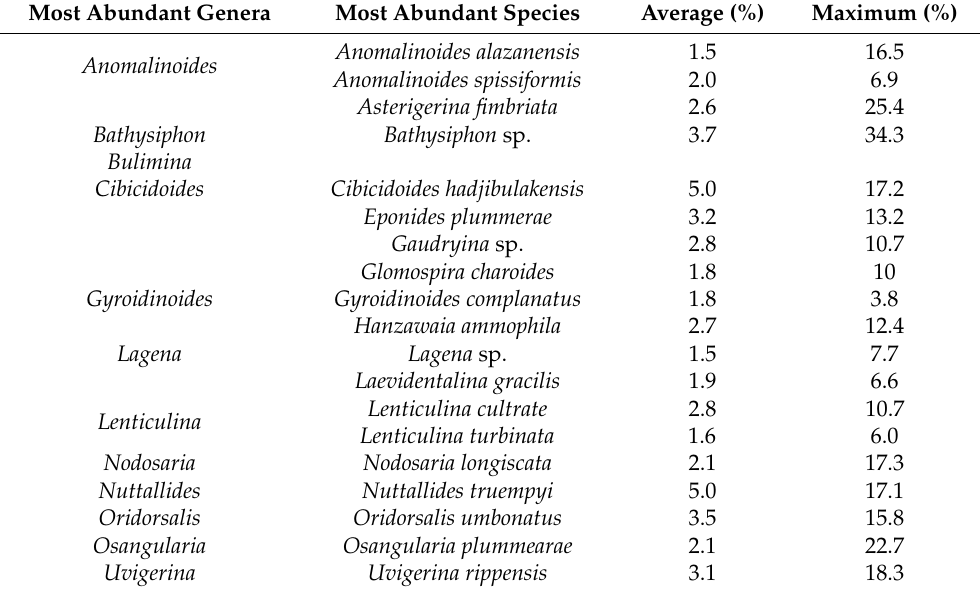
Figure 3. Indices of carbonate dissolution and benthic foraminiferal assemblage’s parameters from the Baskil section. P/B: planktic to benthic (P/B) ratio calculated as P/(P + B) × 100 expressed as percentages of planktonic foraminifera in the total foraminiferal assemblage; FI: Fragmentation index calculated according to [60]; C/A: calcareous-agglutinated ratio expressed as C/(A + C) × 100; B/triserial: percentages of bi-triserial morphogroups; E/I: epifaunal to infaunal (E/I) ratio calculated as E/(E + I) × 100; S: species richness; Fisher α index, H’: Shannon index; D: dominance; J: evenness, E: equitability (calculated using the PAST—Palaeontological Statistics data analysis package, [72]). Magneto-biostratigraphy and lithostratigraphy as in Figure 2. Table 1. Most abundant benthic foraminiferal genera and species from the Baskil